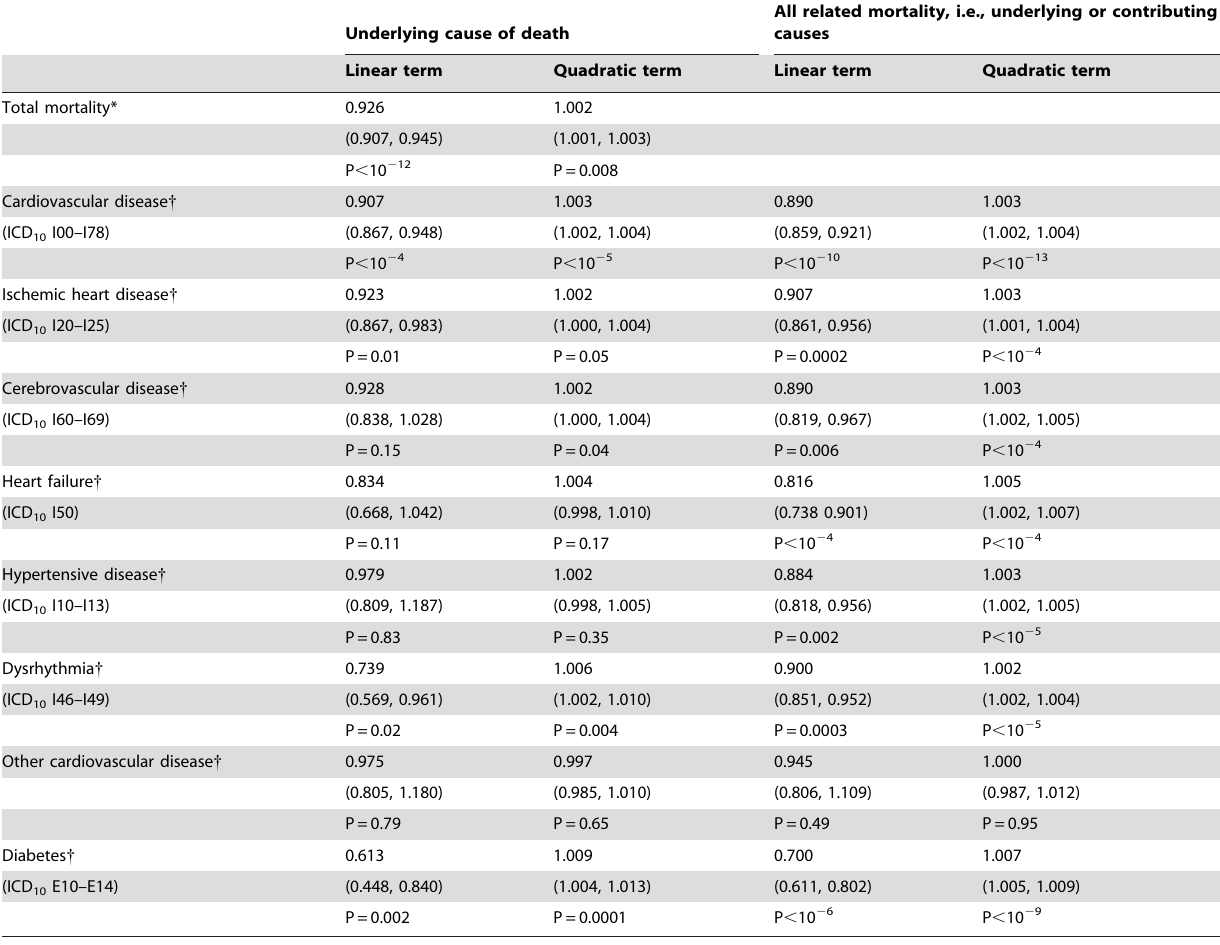
All related mortality, i.e., underlying or contributing